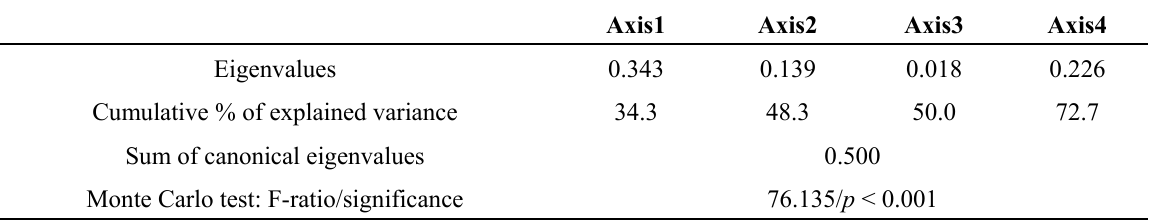
Table 4. Redundancy Analysis (RDA) of the phenological and productivity variables averaged within the EFTs as dependent variables and the climatic constraints averaged within the EFTs as explanatory